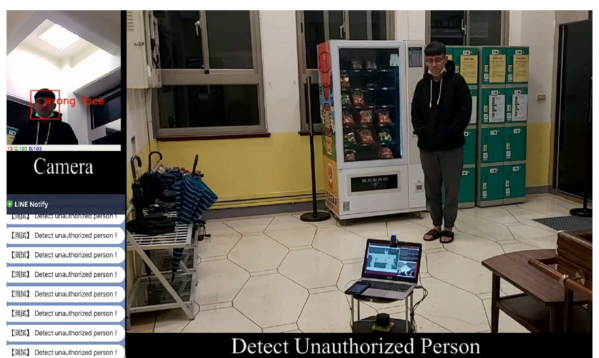
Figure 37. Face recognition of unauthorized person in second indoor